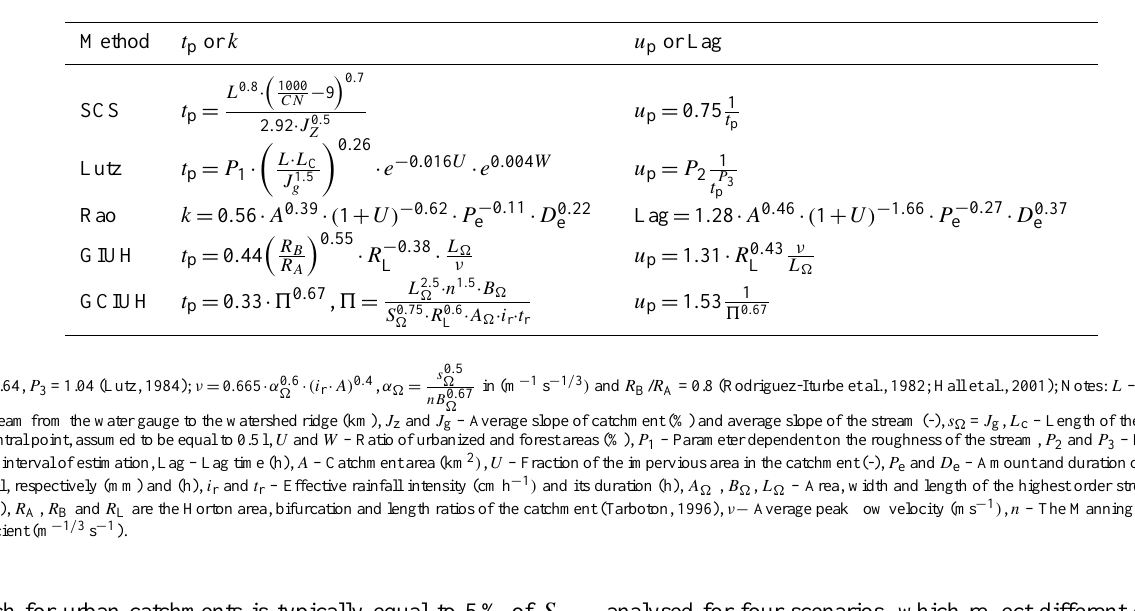
Table 1. Methods used to derive IUH characteristics and Nash model